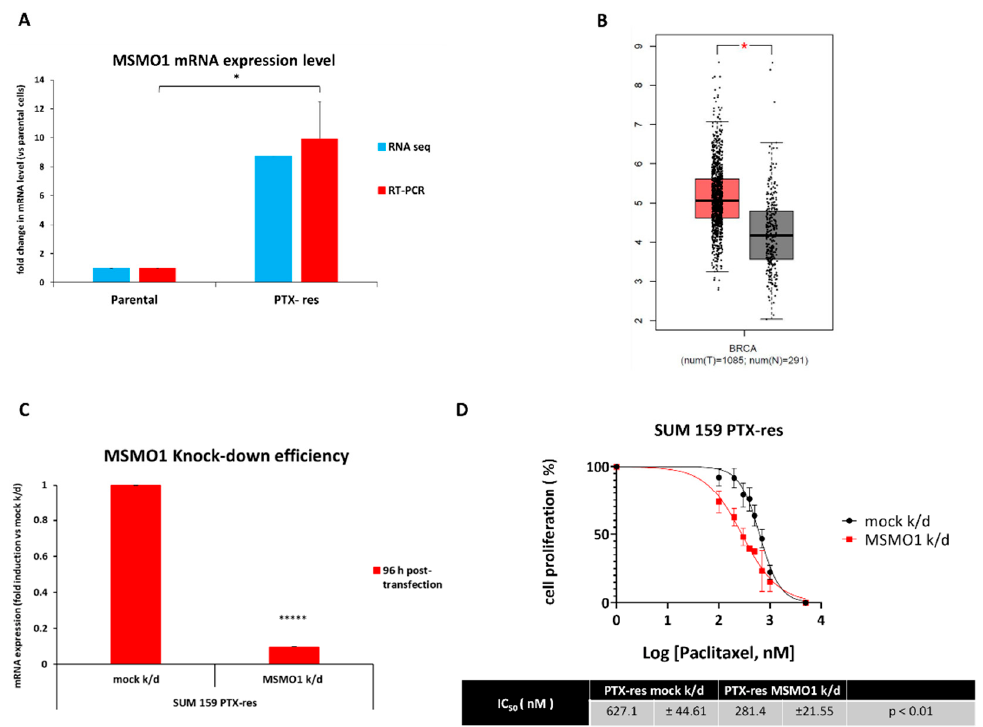
Figure 10. MSMO1 is overexpressed and mediates paclitaxel resistance in SUM159 PTX-res cells. ( A ) MSMO1 mRNA levels in SUM159 parental and PTX-res cells as determined by RNA-seq and RT-qPCR. ( B ) Box plot shows that MSMO1 is overexpressed in breast tumors vs. normal tissue (data from GEPIA). ( C ) RT-PCR for MSMO1 mRNA levels in SUM159 PTX-res cells after knock-down. ( D ) SUM159 PTX-res cells were knocked-down for MSMO1 and then treated with different concen- trations of paclitaxel. Cell confluency was measured using the Incucyte Zoom live-cell analysis sys- tem. The paclitaxel IC 50 values of SUM159 PTX-res mock and SUM159 PTX-res MSMO1 knock-down cells were calculated using Graphpad Prism version 8.01. Data from three independent experiments performed in triplicate are shown. Error bars represent the SEM of biological replicates. *: p < 0.05, *****: p < 0.00001.